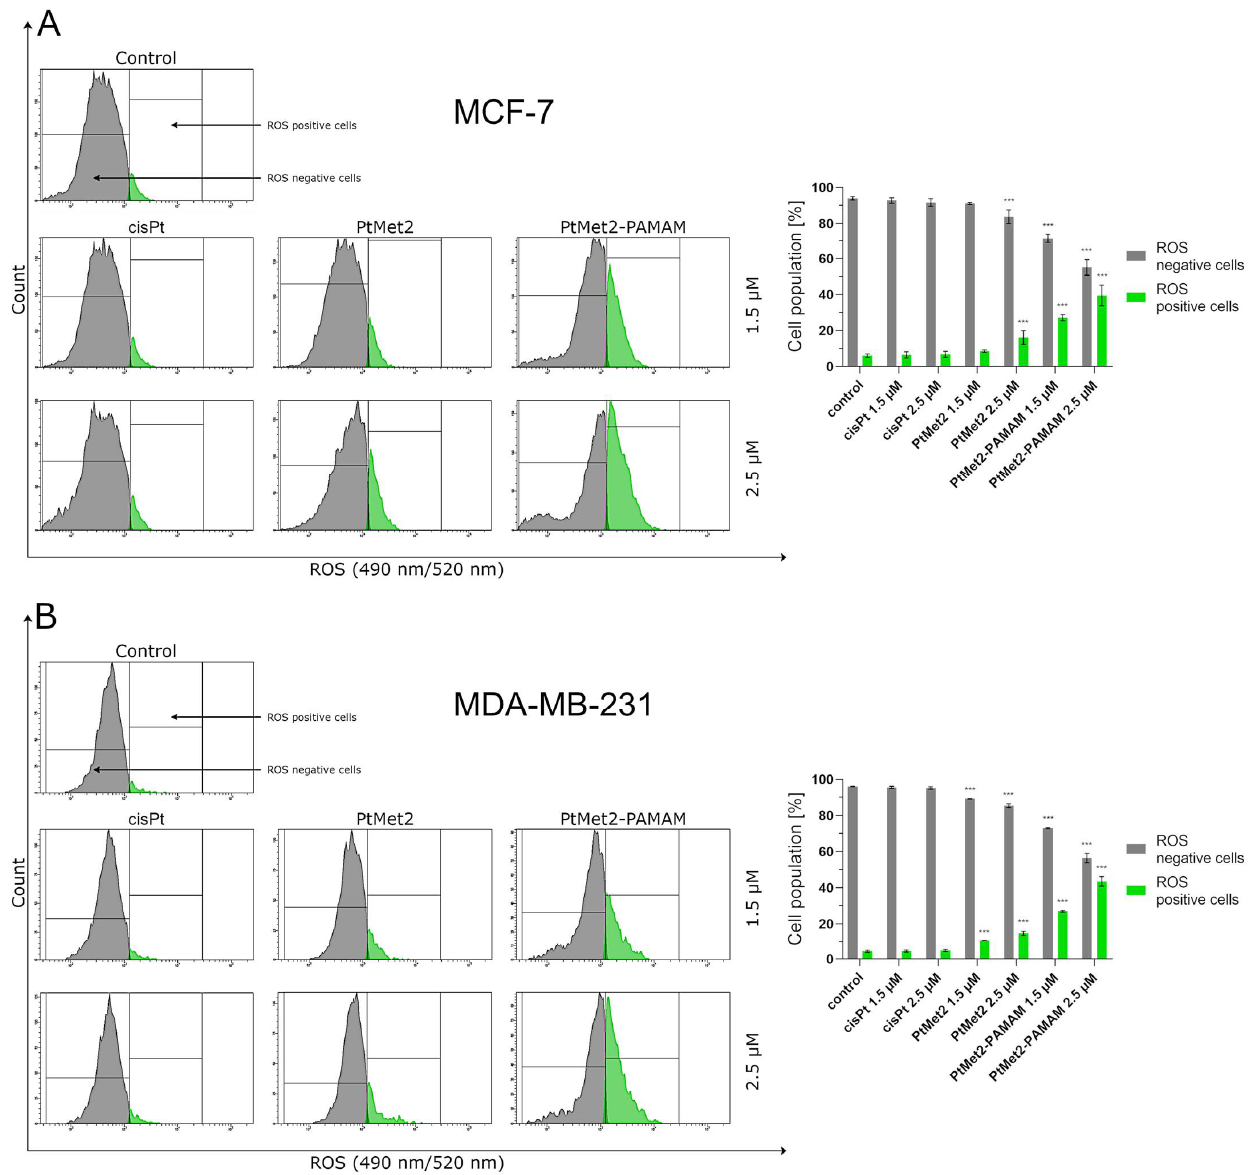
Figure 9. ROS induction in MCF-7 ( A ) and MDA-MB-231 ( B ) breast cancer cells measured by flow cytometry using Intracellular Total ROS Activity Assay (green color) compared to negative control cells (gray color) after 24 h incubation with PtMet2, PtMet2–PAMAM, and cisplatin (1.5 μM and 2.5 μM). Mean percentage values from three independent experiments ( n = 3) done in duplicate are presented. *** p < 0.001 vs. control group.